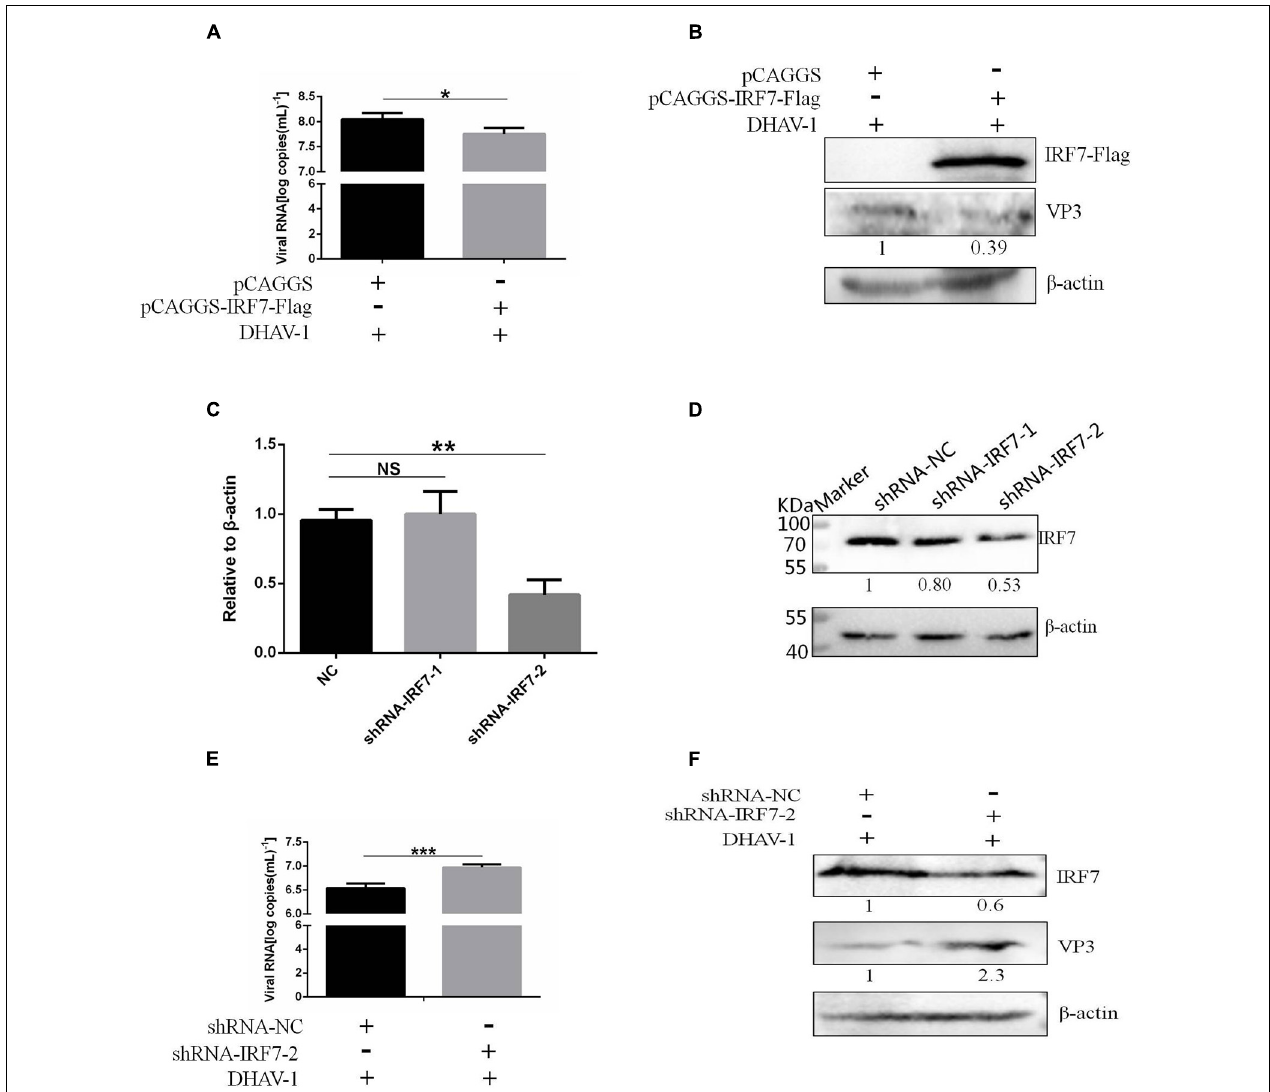
FIGURE 9 | Effect of the IRF7 protein on DHAV-1 replication. pCAGGS-IRF7-Flag or shRNA-IRF7-1/2 was transfected into DEFs, and the pCAGGS and shRNA-NC negative control groups were set. Twenty-four hours after transfection, the cells were infected with the DHAV-1 CH strain at an MOI of 0.4, and cell samples were collected 36 h after transfection. (A) The viral copy number was detected when the IRF7 protein was overexpressed. (B) The structural protein VP3 was detected when the IRF7 protein was overexpressed. (C) The effects of shRNA-IRF7-1 and shRNA-IRF7-2 on the IRF7 mRNA level in DEFs. (D) The effects of shRNA-IRF7-1 and shRNA-IRF7-2 on IRF7 protein expression in DEFs. (E) The viral copy number was detected in DEFs transfected with shRNA-IRF7-2. (F) The structural protein VP3 was detected in DEFs transfected with shRNA-IRF7-2. * P < 0.05, ** P < 0.01, *** P < 0.001, compared with the control